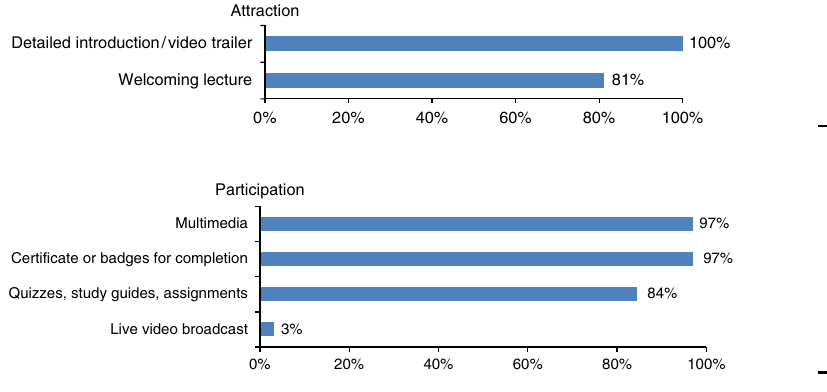
Figure 2. Presence of factors in the participation